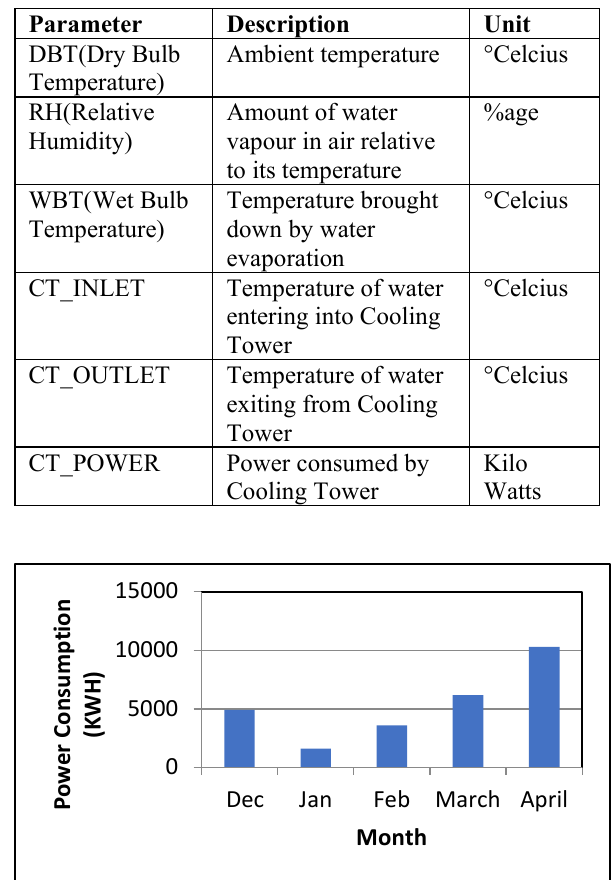
Table 1. Dataset Parameter description